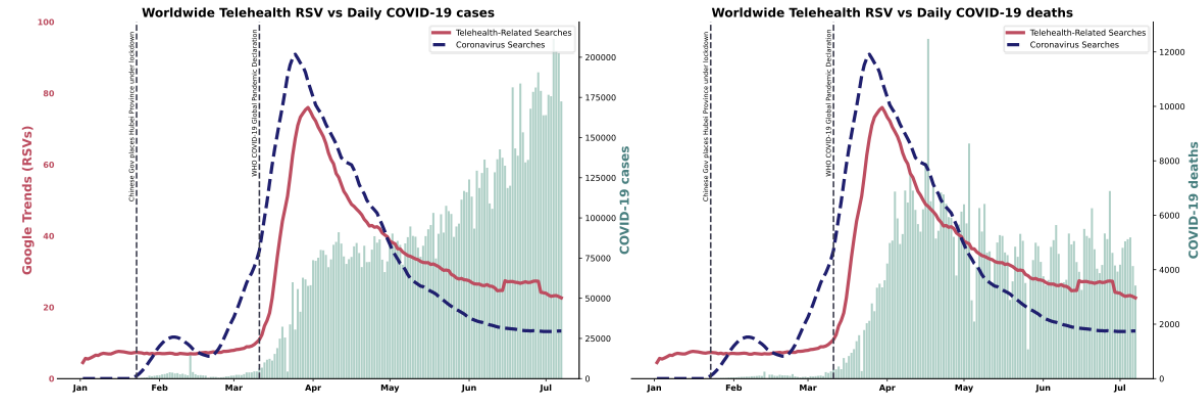
Figure 3. Worldwide time trends for telehealth-related relative search volumes (RSVs) (red) against daily COVID-19 cases (left) and deaths (right). The x axis represents time in individual days from January 1 to July 7, 2020. The left and right y axes represent Google Trends RSVs and COVID-19 cases or deaths, respectively. Blue and red trendlines represent “coronavirus” and telehealth-RSVs, respectively. Teal vertical bars represent daily COVID-10 cases or deaths. Black vertical lines represent two key dates: the start of the Hubei Province lockdown (January 23, 2020) and the declaration of COVID-19 as a pandemic by the World Health Organization (WHO) on March 11,